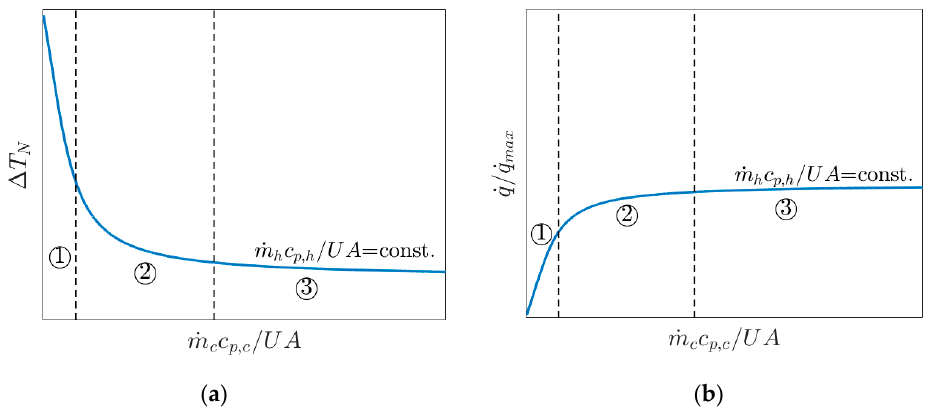
Figure 2. Steady-state profile of the dimensionless ( a ) hot fluid outlet temperature and ( b ) exchanger duty with respect to the dimensionless manipulated flow for a cooler with conventional configuration. The vertical dashed lines delimit the exchanger operation regions.